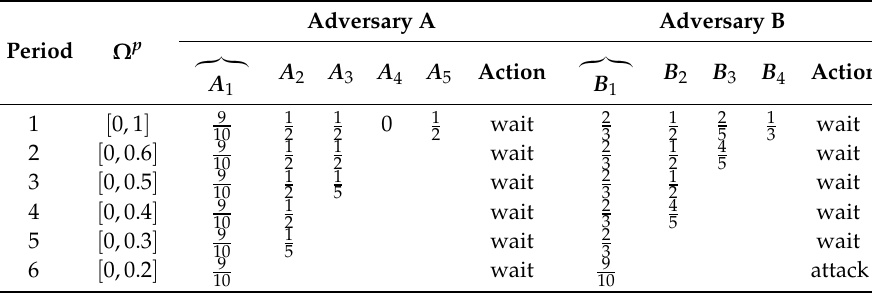
Table 1. Dynamics when true state of world is ω ∈ A 1 = [ 0,0.2 ]